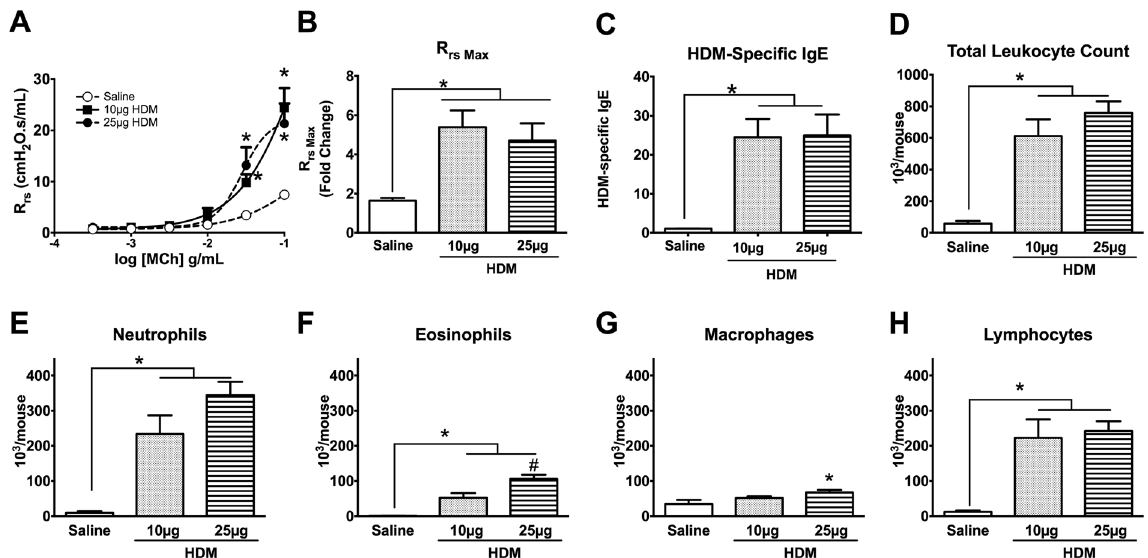
Figure 7. The 10 µ g HDM 4-Week Model exhibits a similar degree of AHR and airway inflammation as the 25 µ g 4-Week Model. The 10 µ g and 25 µ g HDM-exposed mice exhibited significant increases in MCh-induced R rs and R N with respect to Saline ( A,B ). This was observed in the MCh-dose responsive curve and maximum R rs, No differences were observed between the 10 µ g and the 25 µ g HDM groups. Both 10 and 25 µ g HDM-exposed developed similar levels of HDM-specific IgE ( C ) and total BAL fluid leukocyte, neutrophil and lymphocyte counts ( D–H ). However, BAL fluid eosinophil counts were significantly higher in the 25 µ g compared with the 10 µ g HDM mice ( F ). Absolute macrophage counts were significantly increased only in the higher dose HDM model ( G ). * p < 0.05 compared with Saline controls; # p < 0.05 between HDM groups; n =